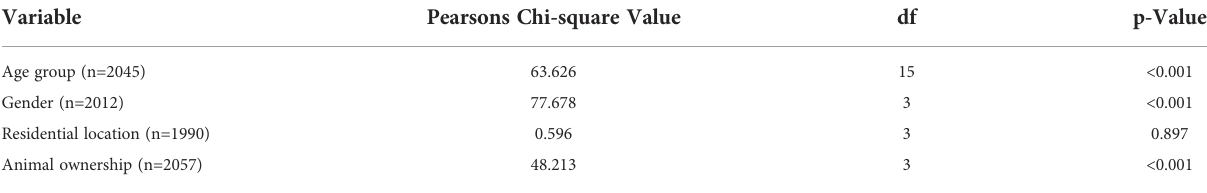
TABLE 3 Association between demographic variables and opinion on sentences for deliberate animal cruelty. Variable